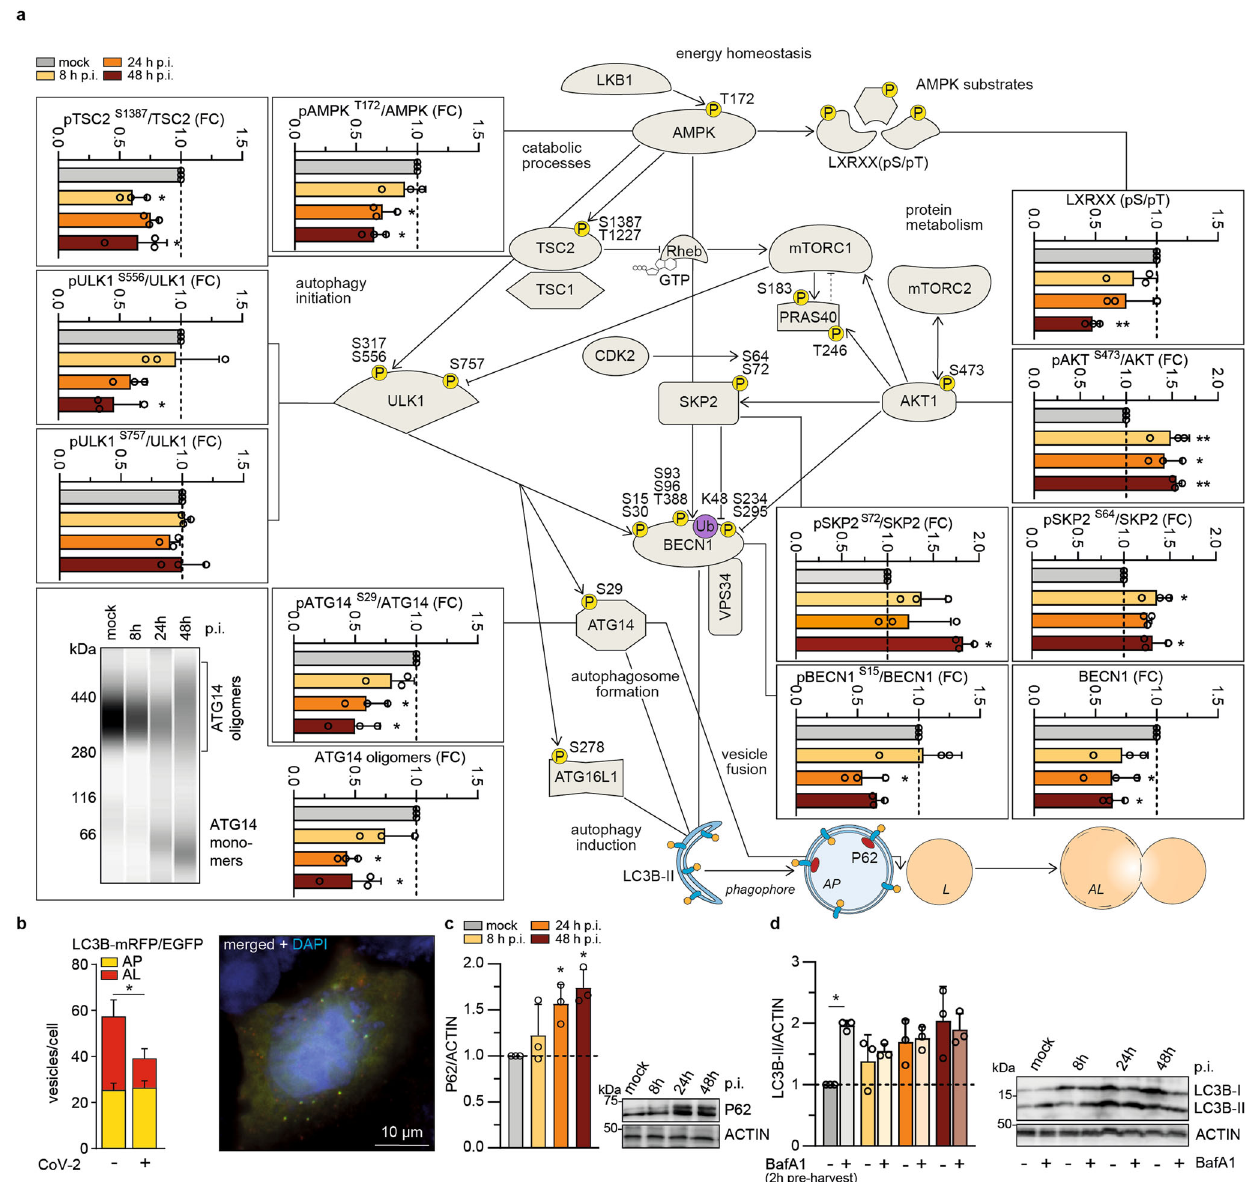
Fig. 2 SARS-CoV-2 limits autophagy signaling and blocks autophagic fl ux. a Protein levels and phosphorylation status of selected autophagy-relevant proteins in SARS-CoV-2-infected VeroFM cells at 8 h, 24h, or 48h post infection (h p.i.) were analyzed by Western blotting. For analysis of ATG14 oligomers (virtual blot, bottom panel, left) proteins were cross-linked 2 h prior to cell harvest and analyzed by Wes (ProteinSimple) capillary electrophoresis 8-48 h p.i. P -values were determined by one-way ANOVA, Bonferroni post hoc test. b Fluorescence microscopy of transfected and SARS-CoV-2-infected VeroFM cells expressing pH-sensitive tandem fl uorescent-tagged LC3B - mRFP/EGFP showed that low pH autophagolysosomes (AL, red) were reduced compared to autophagosomes (AP, green + red = yellow) in virus-infected cells. Microscopic read-out was done by a scientist blind to the experimental conditions. For mock ( n = 44 cells) and SARS-CoV-2-infected ( n = 46 cells) VeroFM cells were analyzed. P-values were determined by two-way ANOVA, Tukey´s post hoc test, mean with SEM. Scale bar = 10 µ M. c Accumulation of autophagy marker P62 in SARS-CoV-2-infected VeroFM cells. d Elevated LC3B-II levels in SARS-CoV-2-infected and ba fi lomycin A1 (BafA1)-pretreated VeroFM cells indicate virus-induced autophagic fl ux inhibition at 8 and 24h p.i. In all panels, error bars denote SEM derived from n = 3 biologically independent samples derived from one experiment. P-values were determined by two-way ANOVA, Sidak post hoc test. p ≤ 0.05 (*), p ≤ 0.01 (**), p ≤ 0.001 (***), p ≤ 0.0001 (****), p > 0.05 (not signi fi cant, ns). Abbreviations: AKT1, RAC-alpha serine/threonine-protein kinase; AMPK, AMP-activated protein kinase; ATG14, autophagy-related 14; ATG16L1, autophagy-related 16 like 1; BafA1, ba fi lomycin A1; BECN1, Beclin-1 protein; CDK2, cyclin-dependent kinase 2; EGFP, enhanced green fl uorescent protein; LC3B, microtubule-associated protein 1 A/1B light chain 3B; LXRXX(pS/pT), phospho-AMPK substrate motif; mRFP, monomeric red fl uorescent protein; mTORC1/2, mechanistic target of rapamycin complex 1/2; PRAS40, proline-rich AKT1 substrate 1; Rheb, Ras homolog enriched in brain; SKP2, S-phase kinase-associated protein 2; TSC1/2, tuberous sclerosis 1/2; ULK1, Unc-51-like kinase 1; VPS34, phosphatidylinositol 3-kinase catalytic subunit type 3.